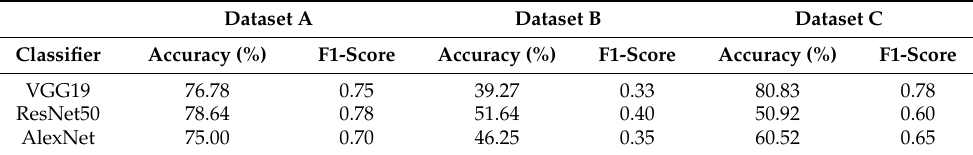
Table 2. The accuracy and F1-score of the selected models.